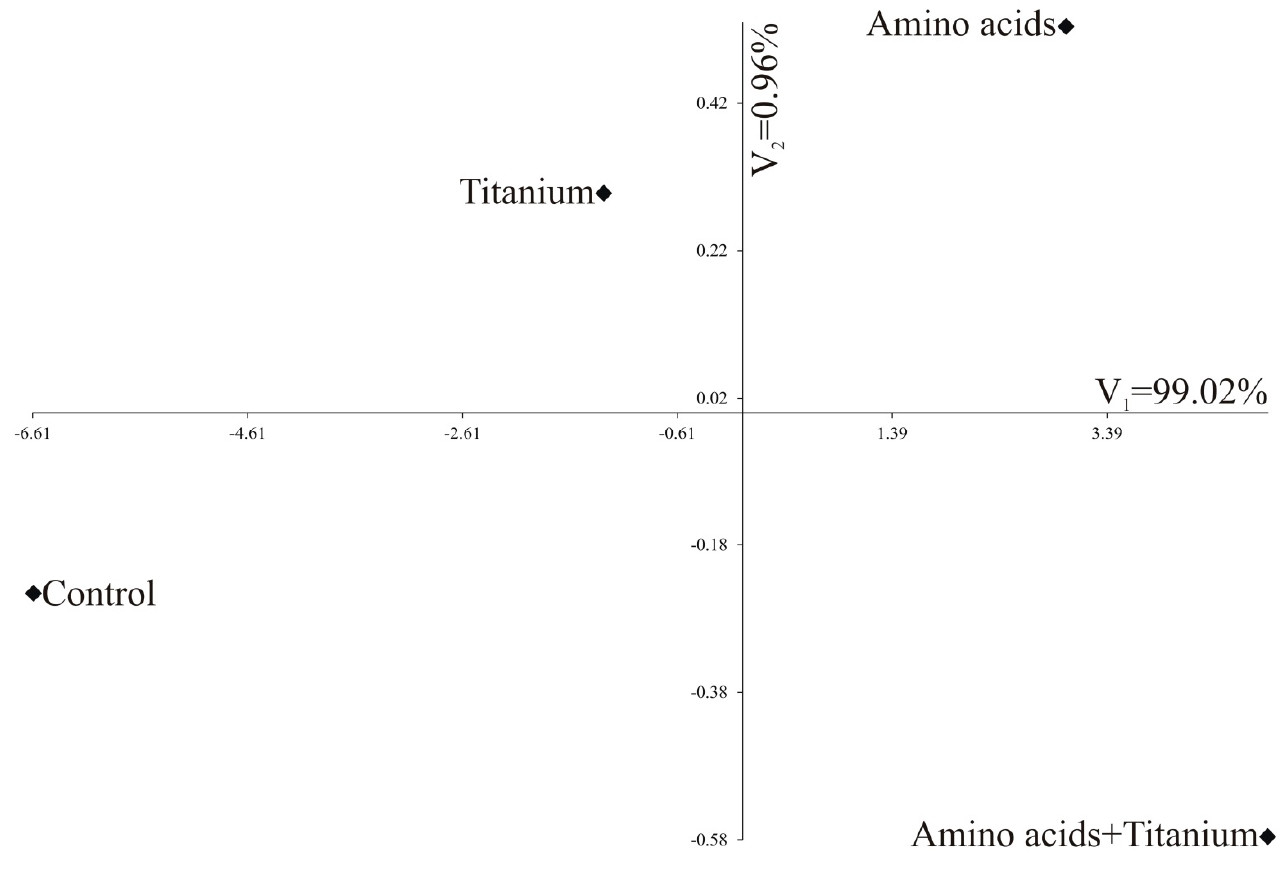
Figure 2. Distribution of biostimulant treatments in space of two first canonical variables for particular cuts and for all three cuts jointly.